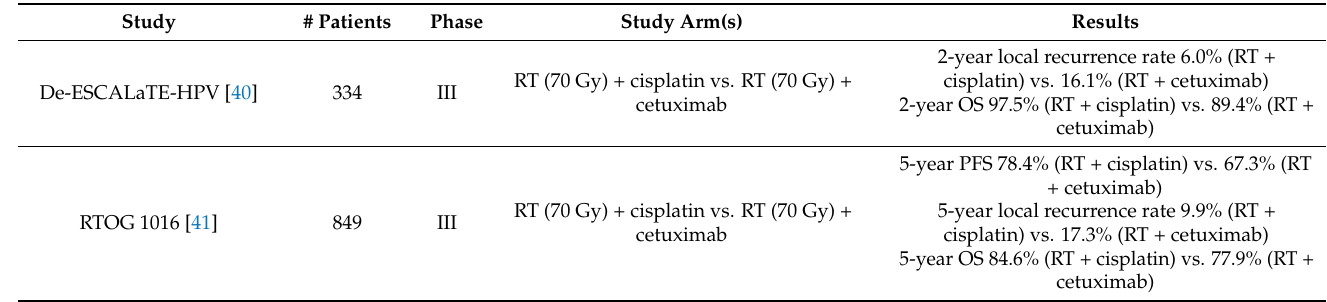
Table 4. Phase III de-escalation trials aiming to replace cisplatin with cetuximab. RT = radiotherapy, OS = overall survival. Study